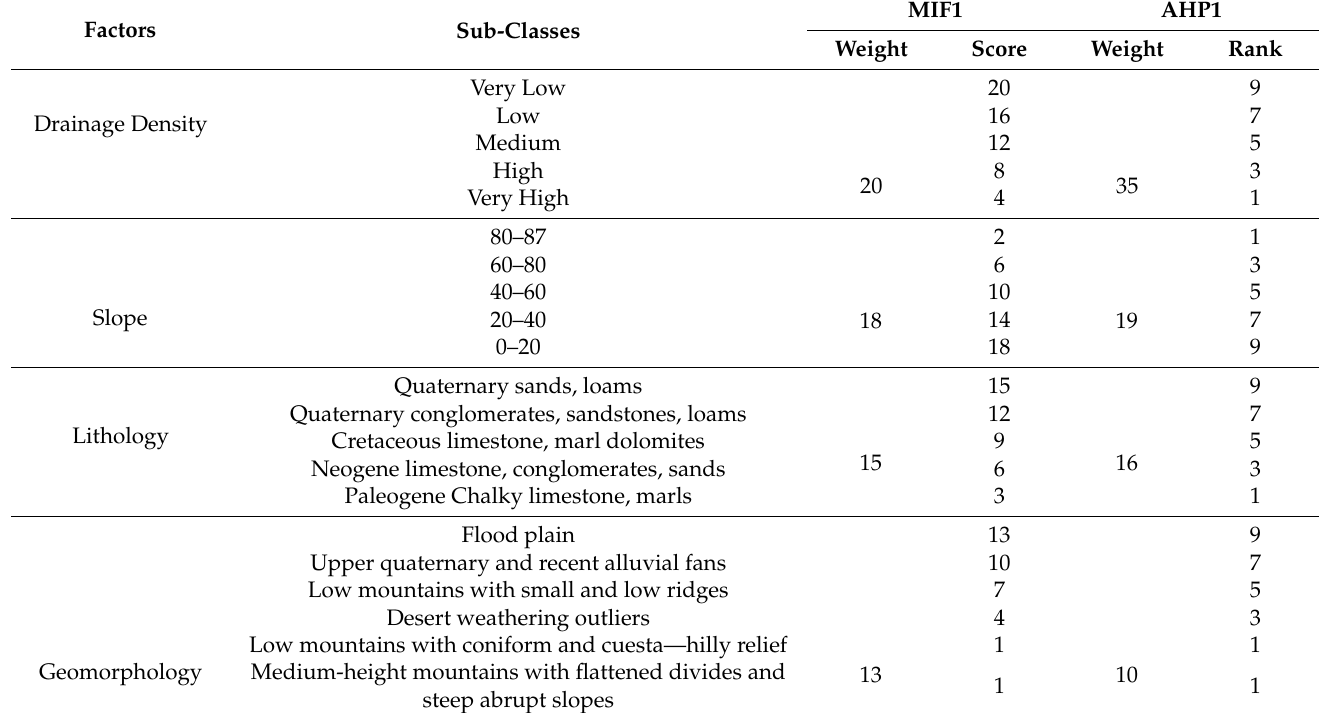
Table A1. Weight and scores of specific characteristics in (MIF1 and AHP1) are assigned to factors that influence